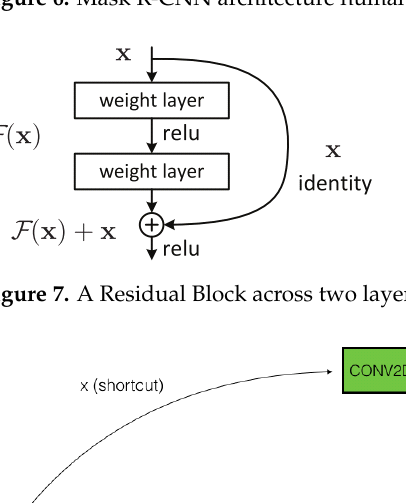
Figure 6. Mask R-CNN architecture human instance segmentation in images.